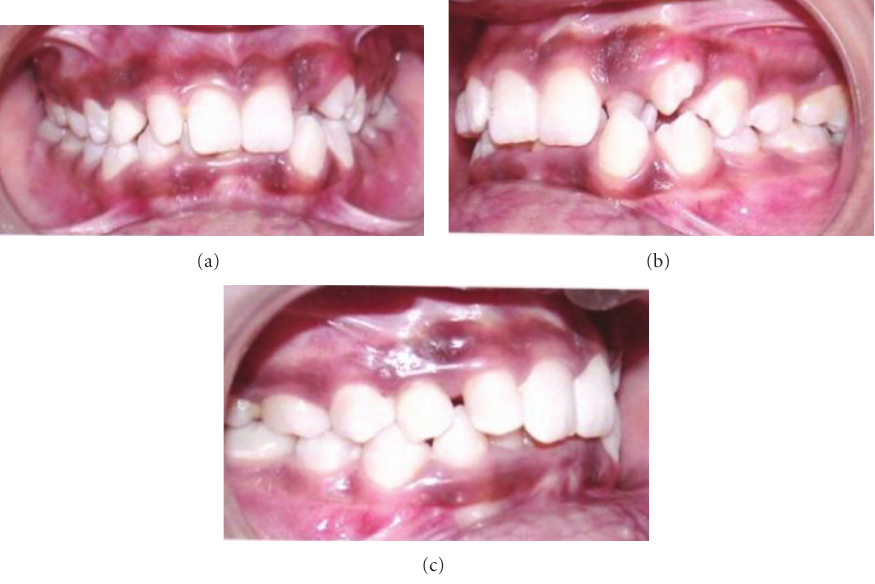
Figure 2: Anterior deep bite with crowding in upper and lower